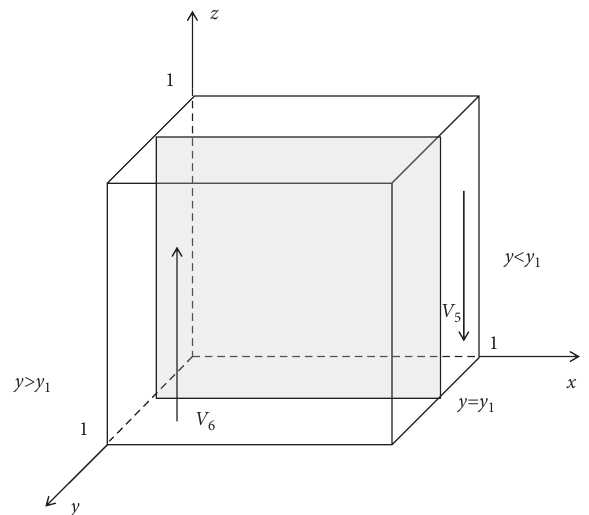
Figure 5: The dynamic trend diagram of P2P lending borrowers.